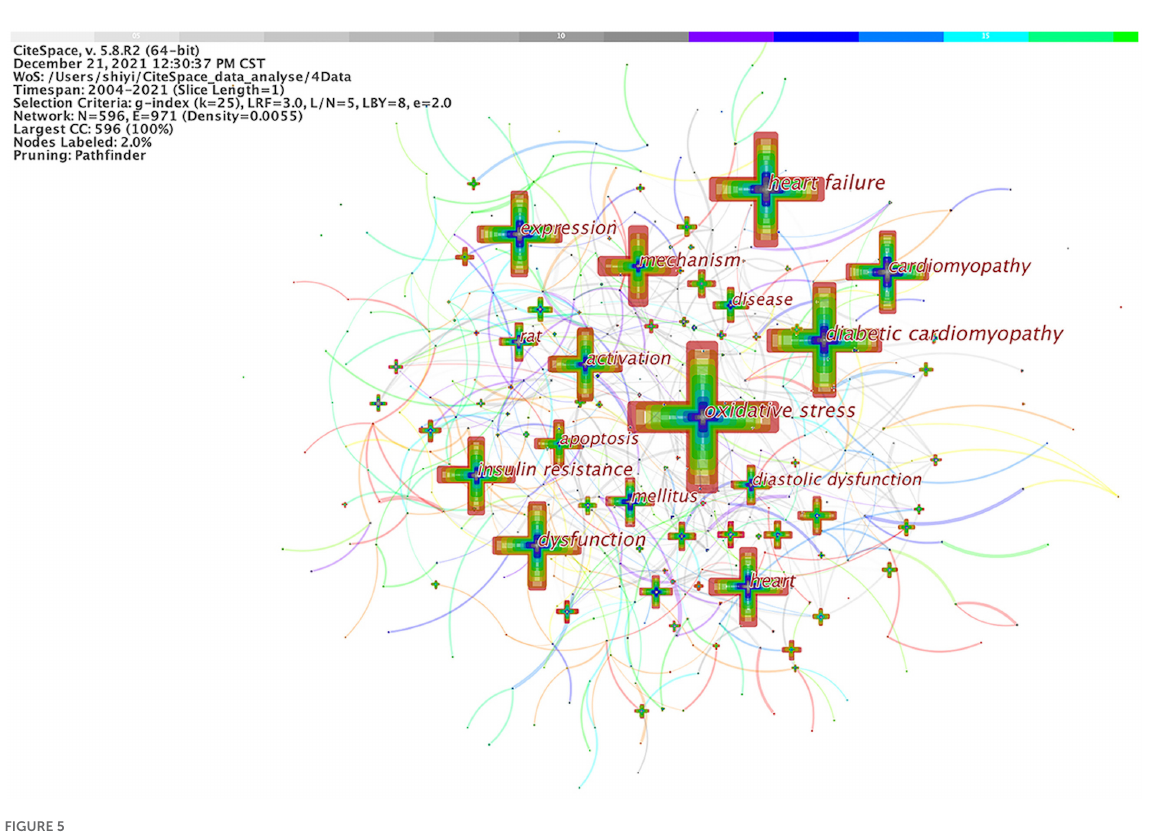
FIGURE5 Analysis of co-occurring keywords in DCM